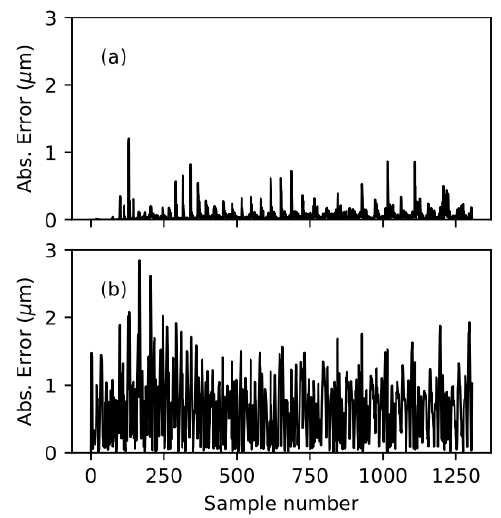
Figure 11. Absolute error of ( a ) the ELM − SVM model and ( b ) the GPIM model [35] for the magne- tostrictive actuator .